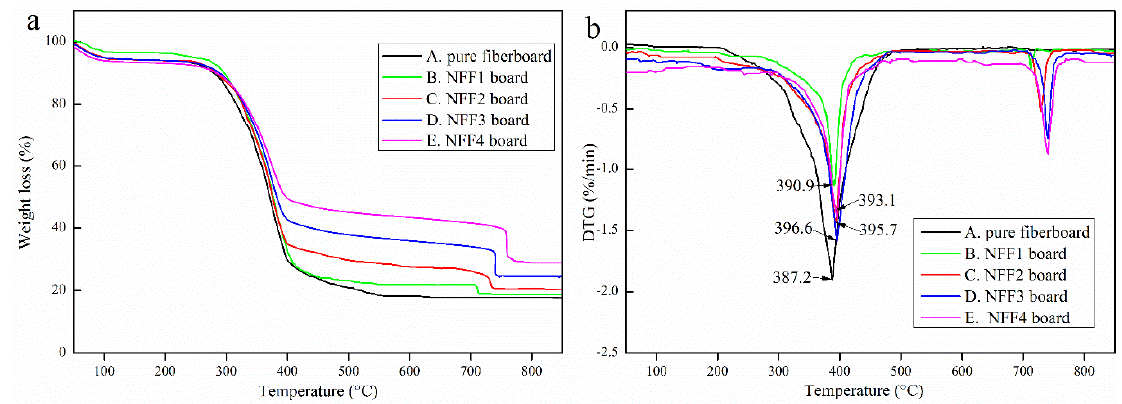
Figure 8. TG ( a ) and DTG ( b ) curves of binderless fiberboard and NFF binderless composite board. (A) pure fiberboard; (B) NFF1 board; (C) NFF2 board; (D) NFF3 board; (E) NFF4 board.